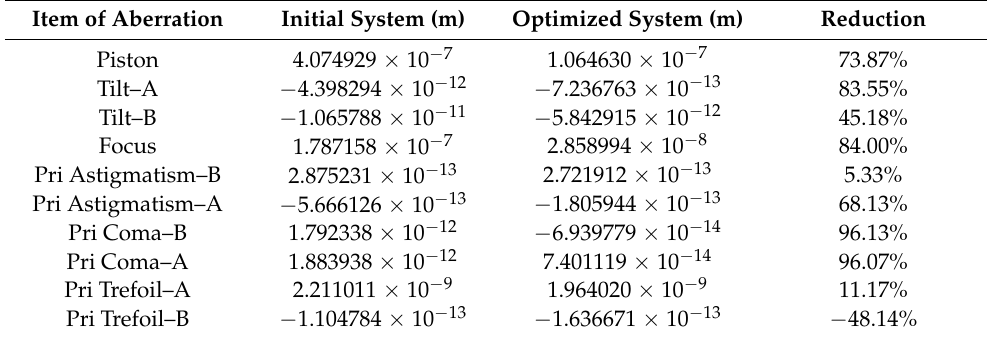
Table 4. Wavefront aberration coefficients of the initial and optimized systems in the vertical optical